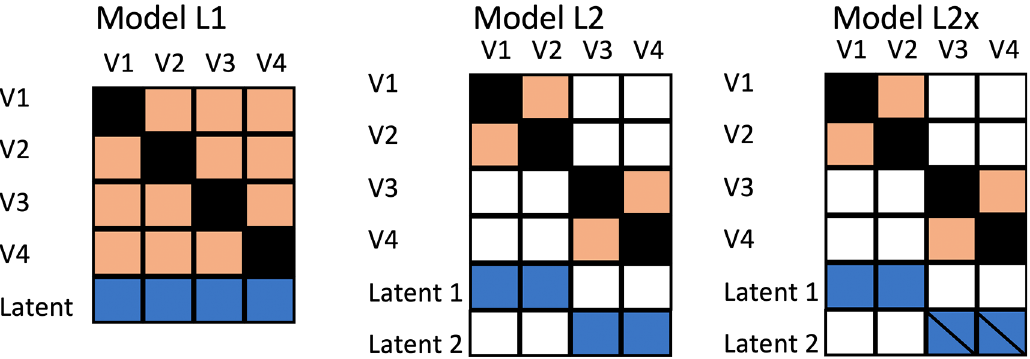
Figure 1. Models for data generation. Heatmap depicts correlations between observed variables V1 to V4 and Latent factors, where colour denotes association. A diagonal line through a latent factor indicates it is not related to